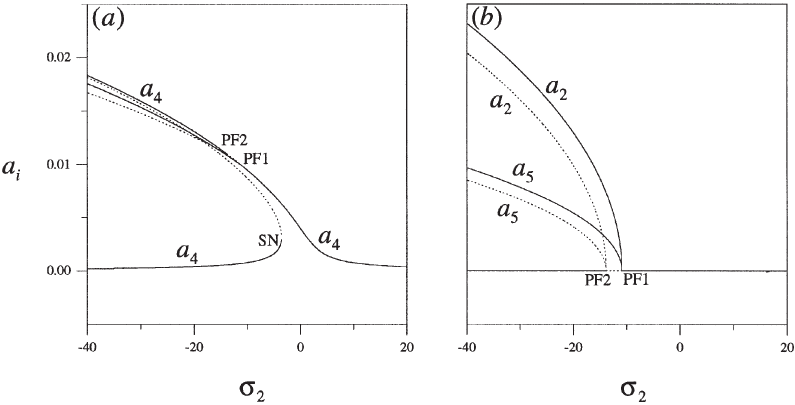
Fig. 2. Frequency-response curves for the case (cid:10) (cid:25) ! 4 (cid:25) 1 ( ! 2 + ! 5 ) when F = 10, (cid:27) 1 = 10, (cid:22) 2 = 0 : 0635, (cid:22) 4 = 0 : 0573, and (cid:22) 5 = 0 : 0400. 2 Solid lines (—) denote stable fixed points and dotted lines ( (cid:1)(cid:1)(cid:1) ) denote unstable fixed points. PF1 and PF2 denote supercritical and subcritical pitchfork bifurcations, respectively, and SN denotes a saddle-node bifurcation.